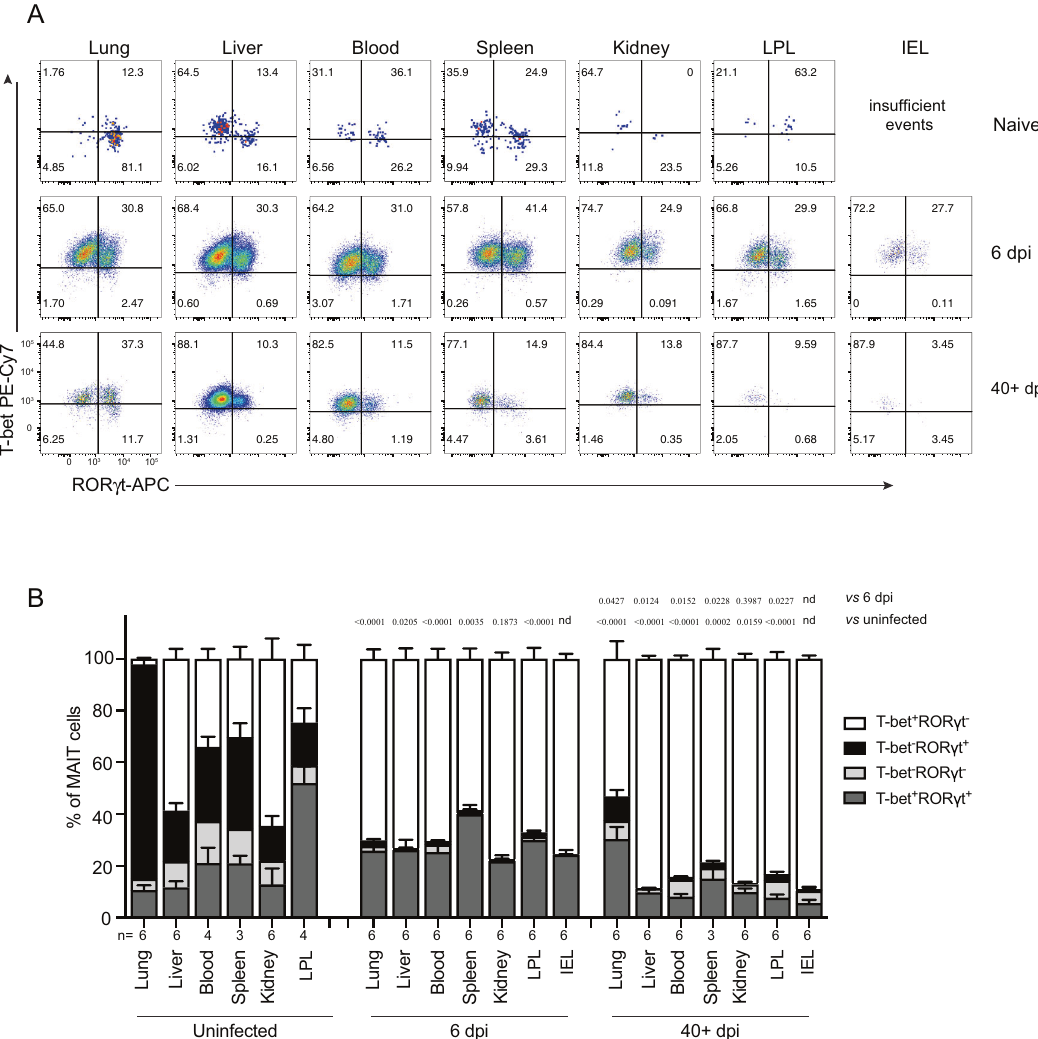
Fig. 4 MAIT cells were polarized to functional MAIT-1 phenotype upon F. tularensis infection. A Representative fl ow cytometry plots showing intranuclear staining for T-bet (representing Th1) and ROR γ t (Th17) in gated MAIT cells from the liver, lungs, spleen, kidneys, LPL, IEL, and blood of naive and infected mice on 6 and 40 + dpi (41 and 68 dpi in two experiments) with 10 4 CFU F. tularensis LVS i.v. Numbers in quadrants represent cell percentage. It is noteworthy that IEL from naive mice yielded insuf fi cient numbers of MAIT cells for accurate assessment of transcription factor expression and, thus, were omitted from our analysis. B Percentage of MAIT cells expressing combinations of T-bet and ROR γ t from the same mice in A . Pooled data from two independent experiments (mean ± SEM, n = 3 – 6 mice per group, as indicated). One-way ANOVA with Tukey ’ s multiple comparisons test was performed on MAIT-1% in each organ (except for IEL) between time points as indicated; p -values are indicated, nd; not determined. Source data are provided as a Source Data fi